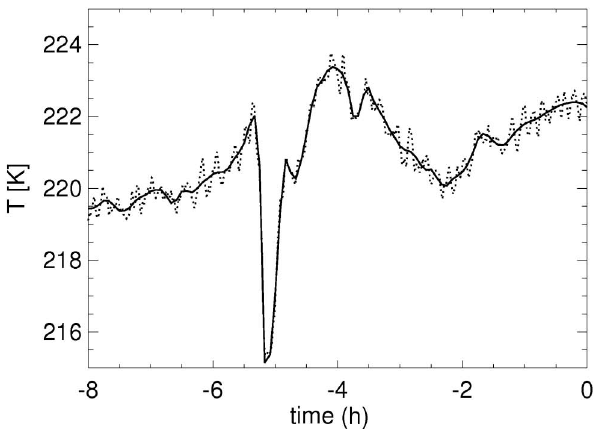
Fig. 4. Solid black line: temperature along a COSMO-7-based LA- GRANTO trajectory in about 9km altitude (close to cloud “L”). Dotted line: same trajectory with superimposed small-scale tem- perature fluctuations ( dT / dt ) ss (random superposition). The cooling rate spectrum has been determined from the variance (0.2K 2 ) and frequencies of ( dT / dt ) ss with wavelengths smaller than 30km (see text) in agreement with the vertical wind measurements made dur- ing the SUCCESS campaign (see Hoyle et al.,